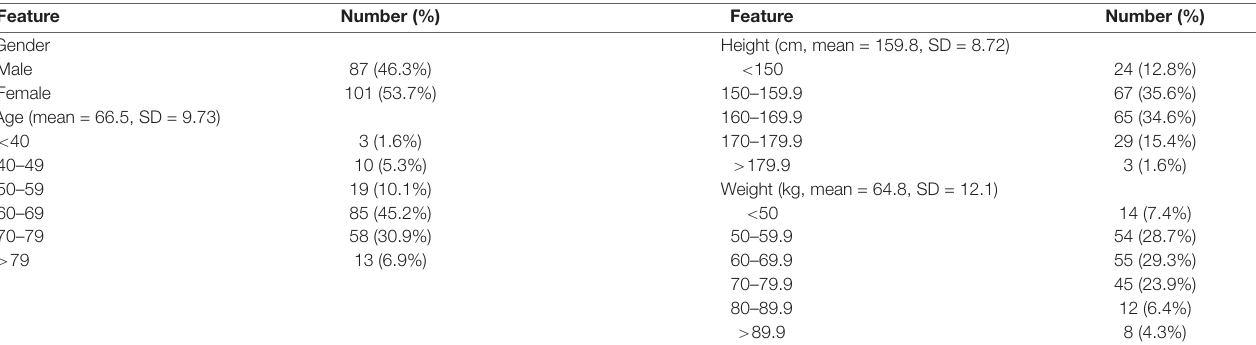
TABLE 3 | Characteristics of